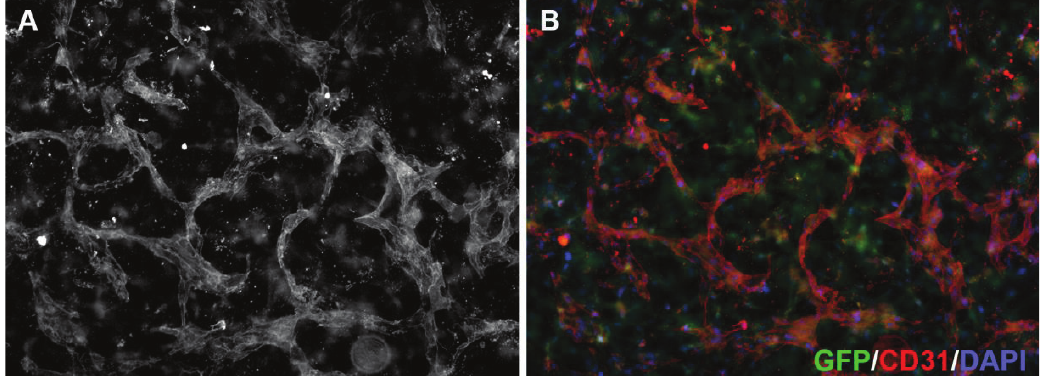
Figure 4. 3D neoangiogenesis model. Human microvascular endothelial cells grown in a collagen gel containing green fluorescent protein (GFP)-expressing fibroblasts (green in B ) for 144 h to allow the formation of a three-dimensional vascular network, were fixed and incubated with an antibody against CD31 ( A ; red in B ) and stained with DAPI (blue in B ). Tube formation and branching frequency are used to quantify anti-angiogenic drug